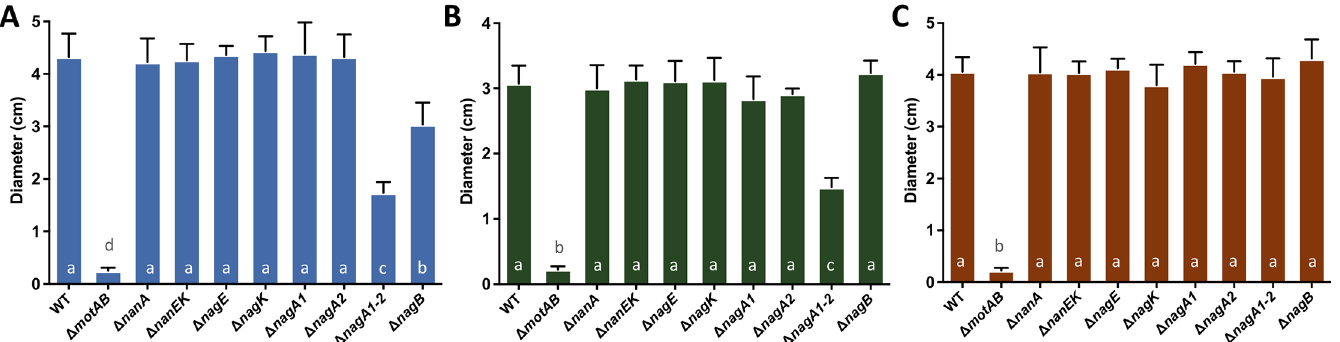
Fig 5. Motility of V . cholerae mutants in the presence of environmental reservoirs. The motility responses of different mutants involved in the catabolism of Neu5Ac and GlcNAc were tested on soft agar plates containing 0.1% Glycerol supplemented with 0.01% A) hexaacetyl-chitohexaose B) Microcystis aeruginosa C) oyster gill lysate. Columns represent the mean of four independent experiments and error bars the standard deviation. Wild-type N16961 (WT), Δ motAB (non-motile), Δ nanA and Δ nanEK (cannot use Neu5Ac as a carbon source), Δ nagE and Δ nagK (cannot use exogenous or endogenous GlcNAc as a carbon source respectively), Δ nagA1-A2 (cannot use Neu5Ac or GlcNAc as carbon sources and is non-motile on mucin plates) and Δ nagB (cannot use Neu5Ac or GlcNAc as carbon sources). Statistical comparisons were made using one-way ANOVA and comparing diameters of the mutants relative to wild-type using Tukey’s HSD test; bars within a panel with the same letter are not significantly different at alpha = 0.05. In A bars with the same letter are not significantly different at alpha = 0.05 from one another. c and d are significantly different from a and b at P < 0.0001. In B and C bars with the letter a are not significantly different at alpha = 0.05 from one another but are different from b at P <